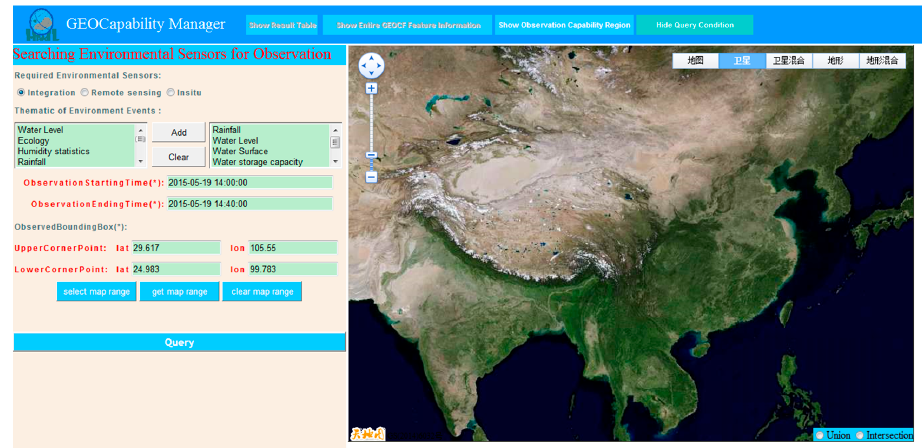
Figure 9. The observation query mission input into the GEOCapabilityManager.